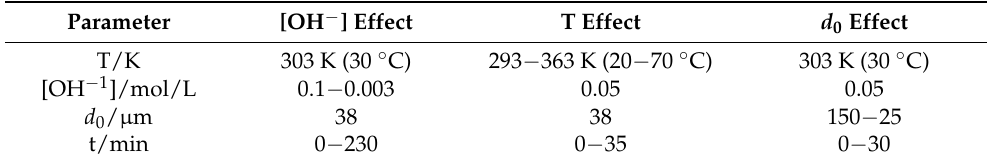
Table 2. Experimental conditions for the decomposition reactions of NH 4 -Na jarosite with arsenic in OH −